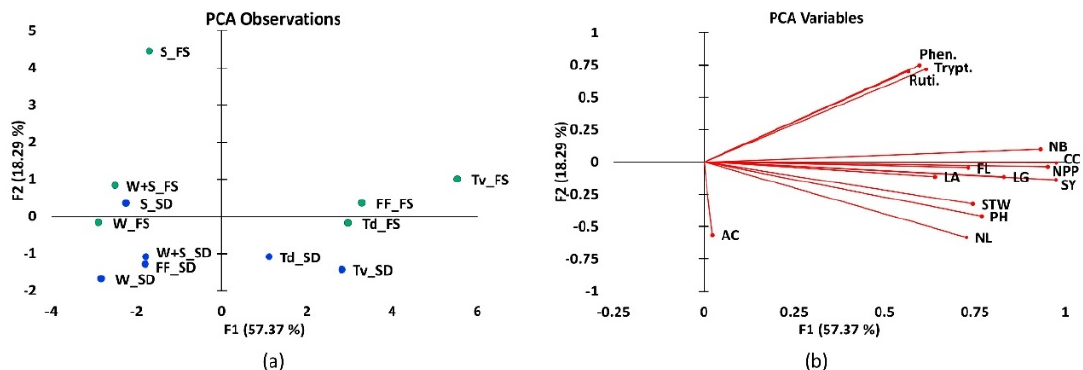
Figure 2. Two-dimensional principal component analysis (PCA) of ( a ) treatments applied using foliar spray and soil drench methods. Green marks indicate the treatments applied using foliar spray (FS) while blue marks indicate the application by soil drench (SD) where Tv = T. vogelii ; Td = T. diversifolia ; FF = foliar spray; W = water only; W + S = water and soap; S = synthetic; and ( b ) the covariance among all growth and metabolite parameters where CC = Chlorophyll content; FL = Flavonoids; AN = Anthocyanins; PH = Plant height; NL = Number of leaves; NB = Number of branches; LA = Leaf area; SW = Stem width; LG = Leaf greenness; NPP = Number of pods per plant; and SY = seed yield/plant.